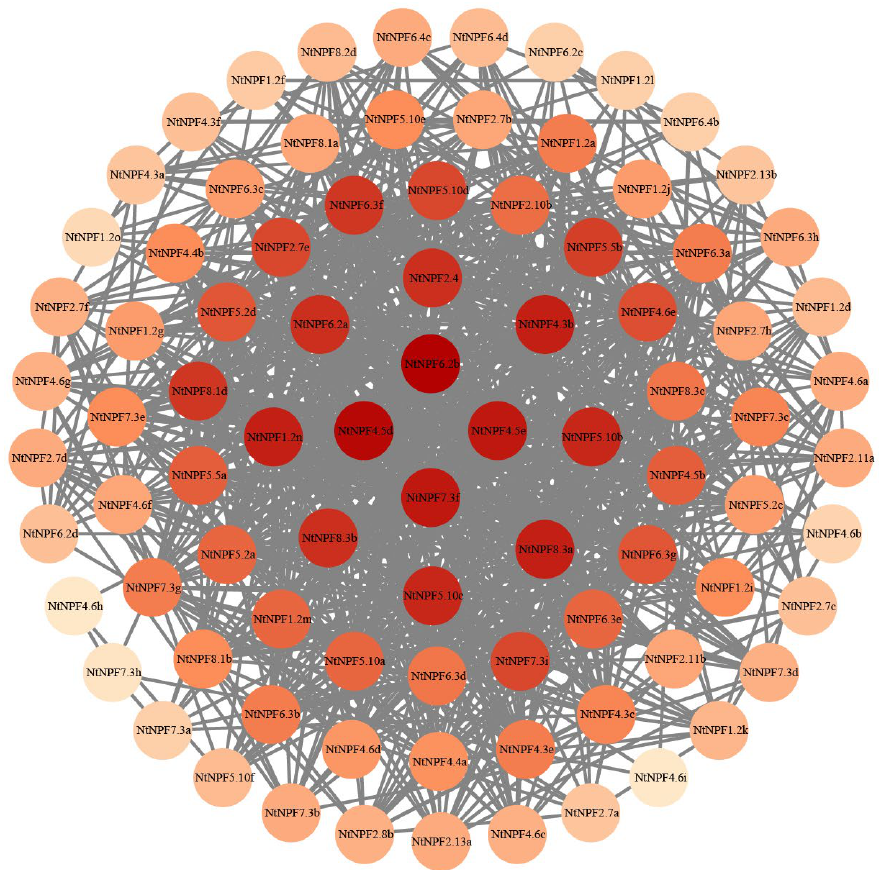
Figure 7. Co-expression networks of NtNPF family genes. Cycle nodes represent genes, and the size of the nodes indicates the strength of the node interrelationship by degree value. The intensity of the interactions between two genes is represented by the width of the lines connecting two nodes. The hub NtNPF genes are located in the network’s center.